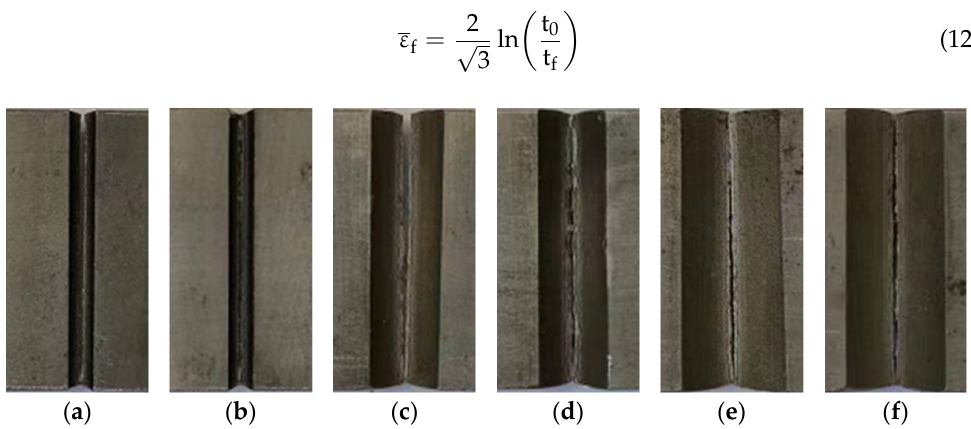
Figure 5. Fracture topography of flat grooved plates: ( a ) FN-1 (1 mm), ( b ) FN-2 (1 mm), ( c ) FN-3 (5 mm), ( d ) FN-4 (5 mm), ( e ) FN-5 (10 mm), ( f ) FN-6 (10 mm). Table 1. Analysis of the test results with respect to the different parameters related to stress and fracture.